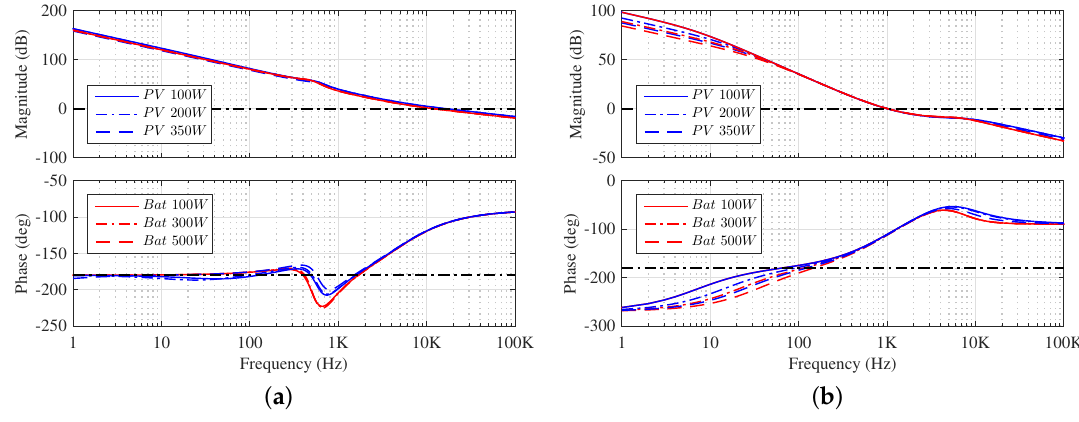
Figure 16. Bode plots of ( a ) T 1 ( s ) and ( b ) T 2 ( s ) when the bus-regulating converter works at different steady-state operating points.